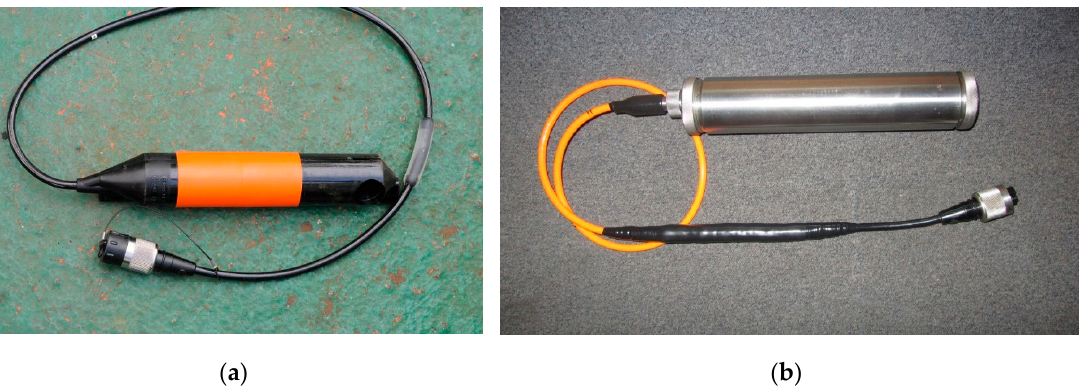
Figure 6. Hydrophones. ( a ) Reference hydrophone at GS-PV-1S; ( b ) molecular-electronic transfer (MET) hydrophone.